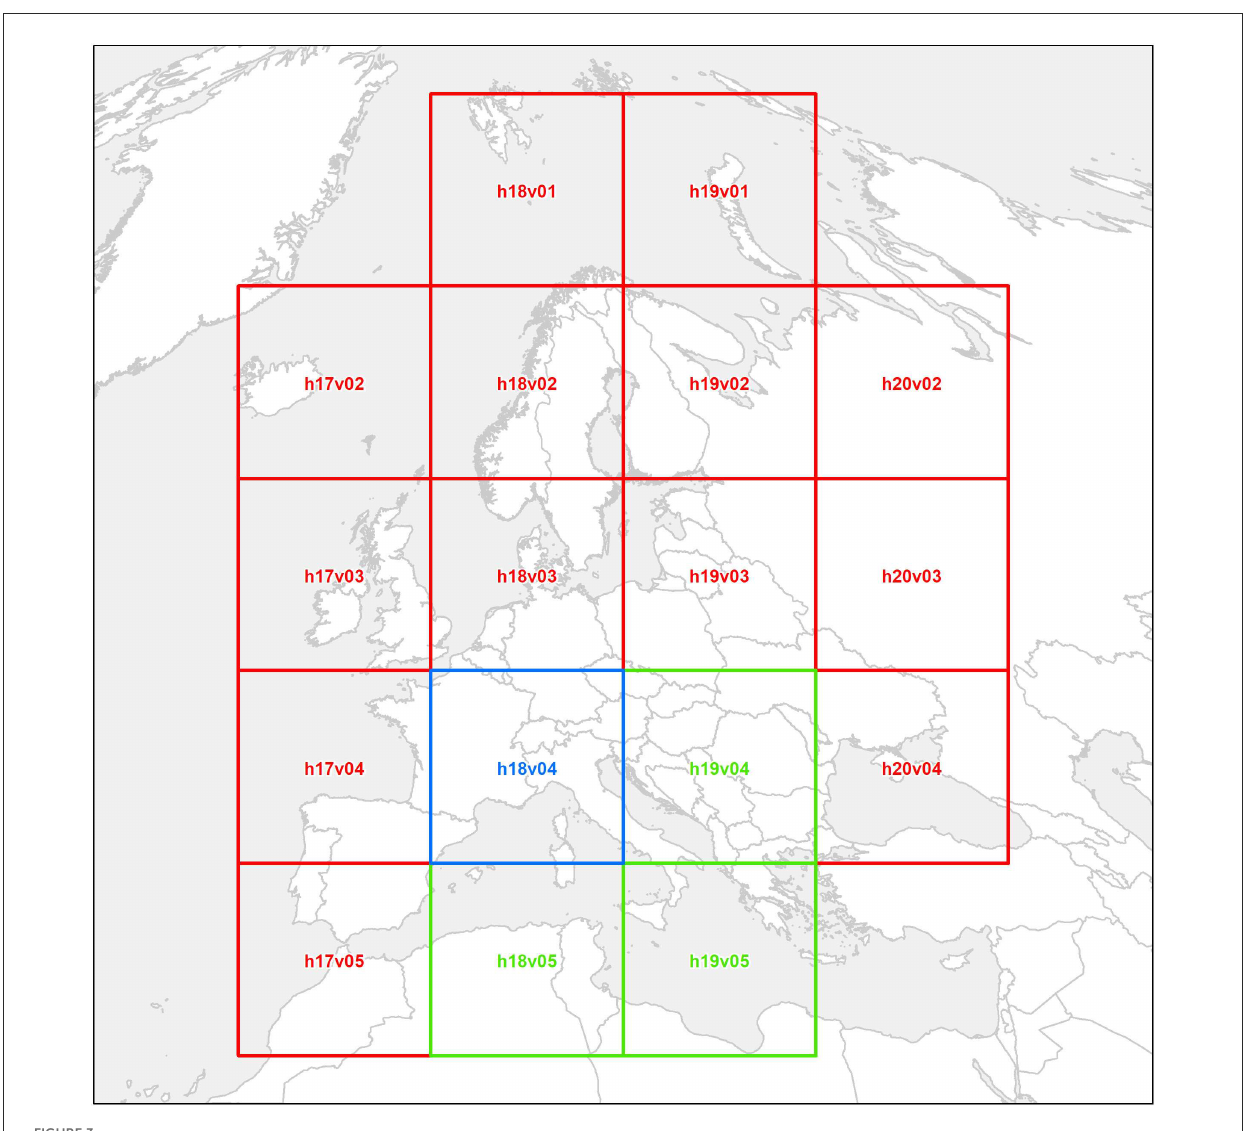
FIGURE3 Terra and Aqua satellites footprints selected for the Local (blue), Country (blue and green), and Continental (blue, green and red)